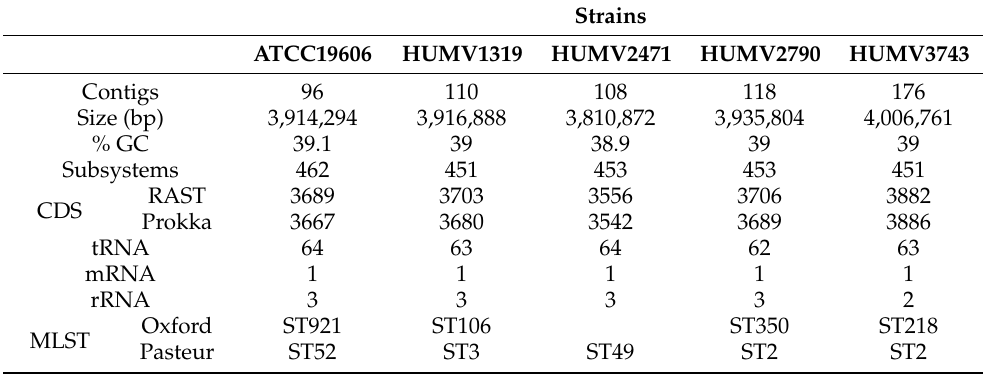
Table 1. Draft A. baumannii genomes features according to RAST and Prokka annotation. In ATCC19606